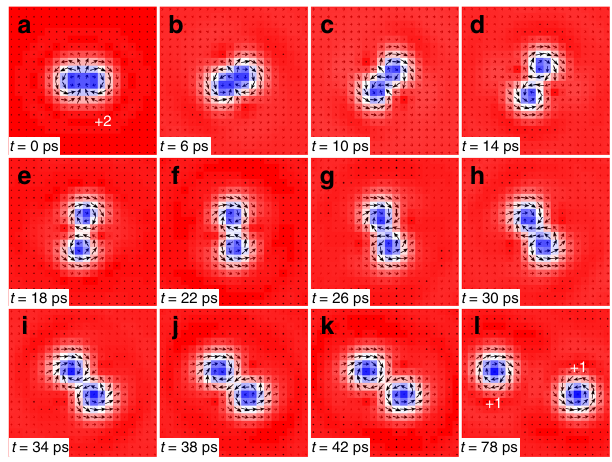
Fig. 9 Forced separation of two skyrmions from a bi-skyrmion with Q = 2. a We fi rst place a relaxed bi-skyrmion. b It starts to rotate counterclockwise under an injected driving current. After forming a clear peanut-like shape, it is separated into two skyrmions as in l . The model is a square element (40 × 40 spins) with the OBC. The parameters are J 2 = − 0.8, J 3 = − 1.2, K = 0.1, H z = 0.1, α = 0.1, and j = 8 × 10 11 A m − 2 . Q is indicated in a and l